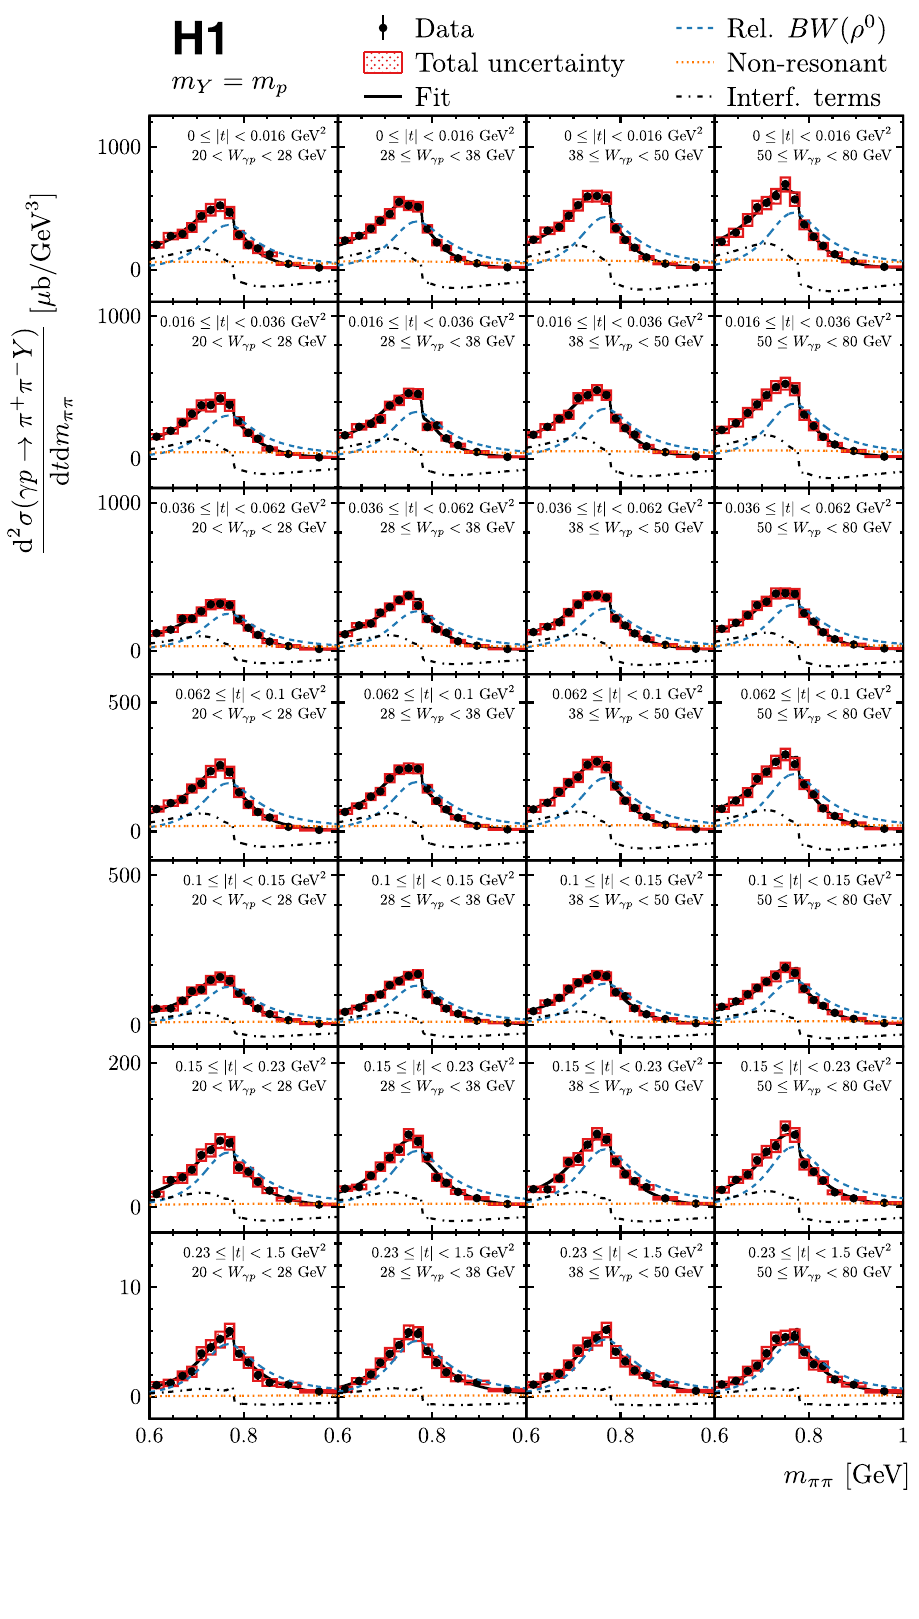
Fig. 15 Elastic ( m Y = m p ) double-differential π + π − photoproduction cross sections d 2 σ(γ p → π + π − p )/ d m ππ d t in bins of W γ p and t and as functions of m ππ . The model that is fitted to the data as described in the text and its components are also